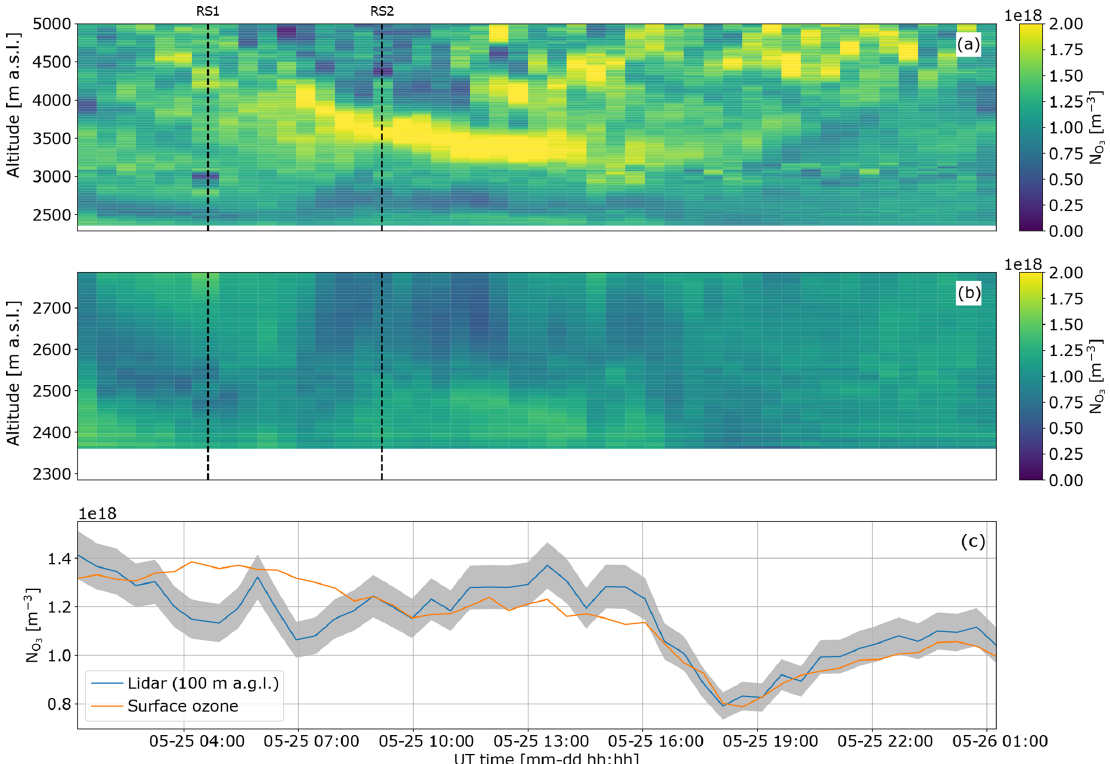
Figure 11. Experiment result overview. (a) Ozone number concentration between ground level and 5000m. (b) Detail of the first 500ma.g.l. (2785ma.s.l.) acquired with the new very near-range receiver. (c) Comparison between the co-located Thermo Scientific Model 49i surface ozone measurements and the lidar retrieval at 100ma.g.l. (2385ma.s.l.), together with 1 σ uncertainty. (d) Difference between the lidar retrieval at 100ma.g.l. (2385ma.s.l.) and the surface ozone meter